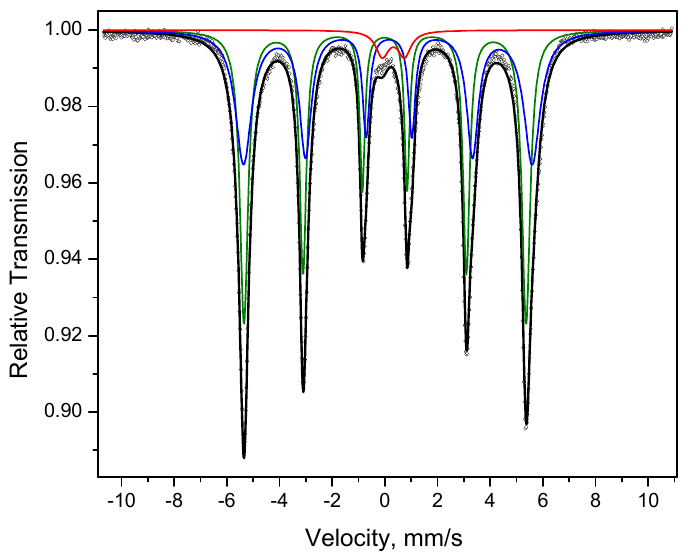
Figure 12. Mössbauer spectrum of the powder alloy obtained by annealing of the Fe@Pd core–shell particles: dots—experimental data, black line—spectrum represented as a superposition of two sextets (green and blue lines) and a doublet (red line).